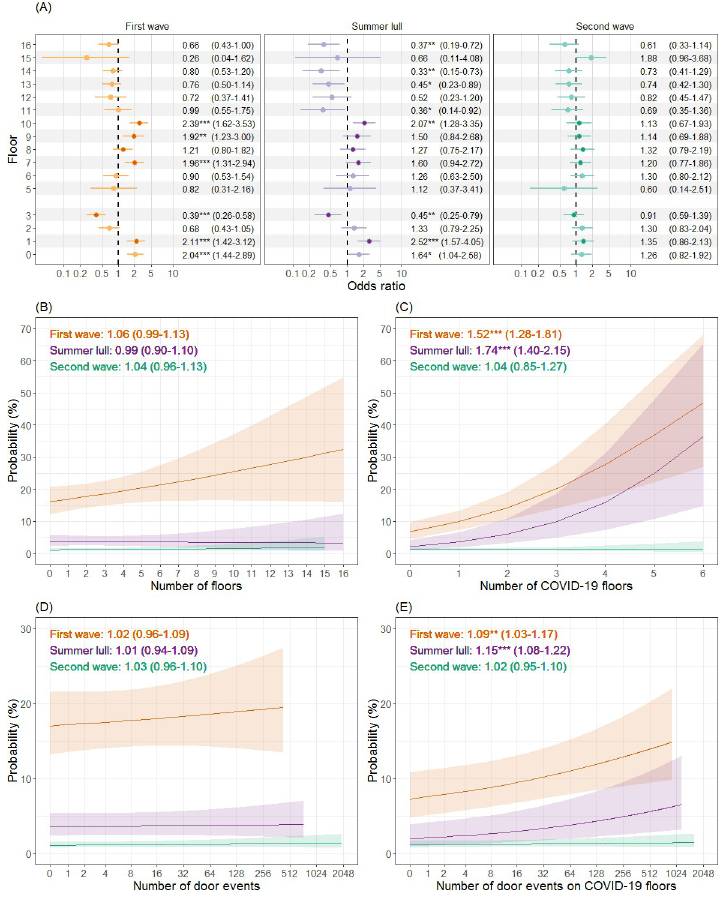
Fig 4. The relationship between healthcare worker mobility and the risk of testing positive for COVID-19 during the first year of the COVID-19 pandemic. Odds ratios, statistical significance ( * p < 0.05; ** p < 0.01; *** p < 0.001) and 95% confidence intervals are estimated from mixed effects logistic regression models, and plotted separately for the first wave (orange), summer lull (purple) and second wave (green). Panel A is a forest plot showing the odds of a positive test when healthcare workers had evidence of activity on a specific floor vs no activity on the floor. Floors that handled the majority of COVID-19 patients ( > 15%) are identified by darker circles, and floor 4 was excluded due to a lack of clinical spaces. Panel B & C show the estimated probability of testing positive for the total number of floors and COVID-19 floors that individuals were active on respectively. Panels D & E show the estimated probability of testing positive for the number of door events on all floors and on COVID-19 floors respectively. The x-axis of panels D & E are on a logged scale (base 2).